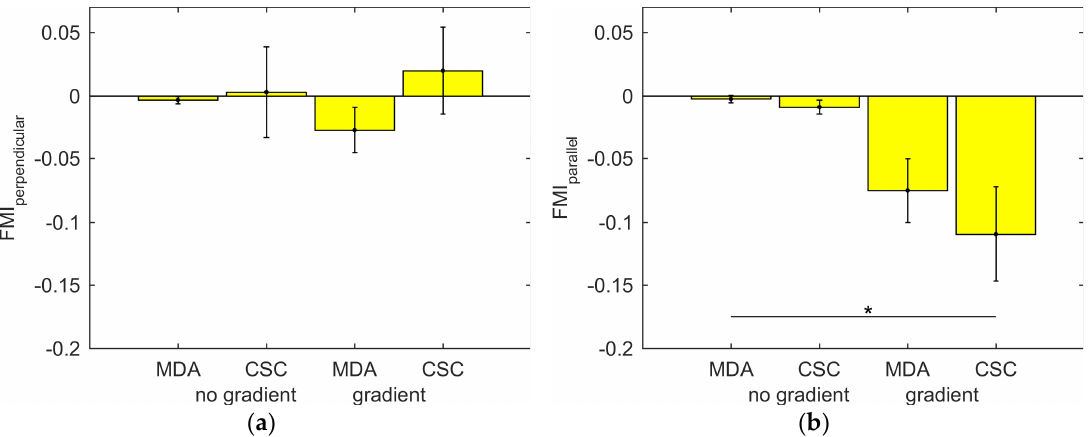
Figure 4. The average forward migration index for all four conditions, defined as the displacement of a cell in the indicated direction divided by the total path length: ( a ) The forward migration index (FMI) perpendicular to the oxygen gradient and ( b ) the FMI parallel to the oxygen gradient. * Statistically significant at P<0.05 using a nonparametric Kruskal–Wallis test.